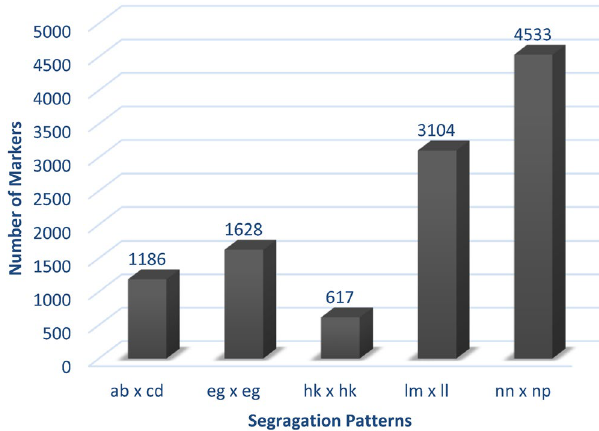
Figure 2. Statistics of genotyped SLAF markers in five segregation